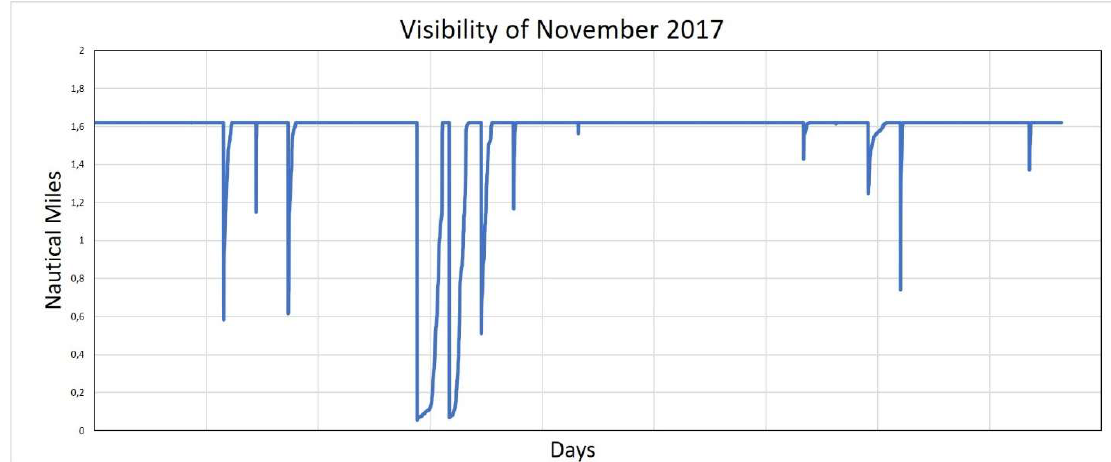
Figure 3. Visibility recorded in the canal of Malamocco in November 2017.